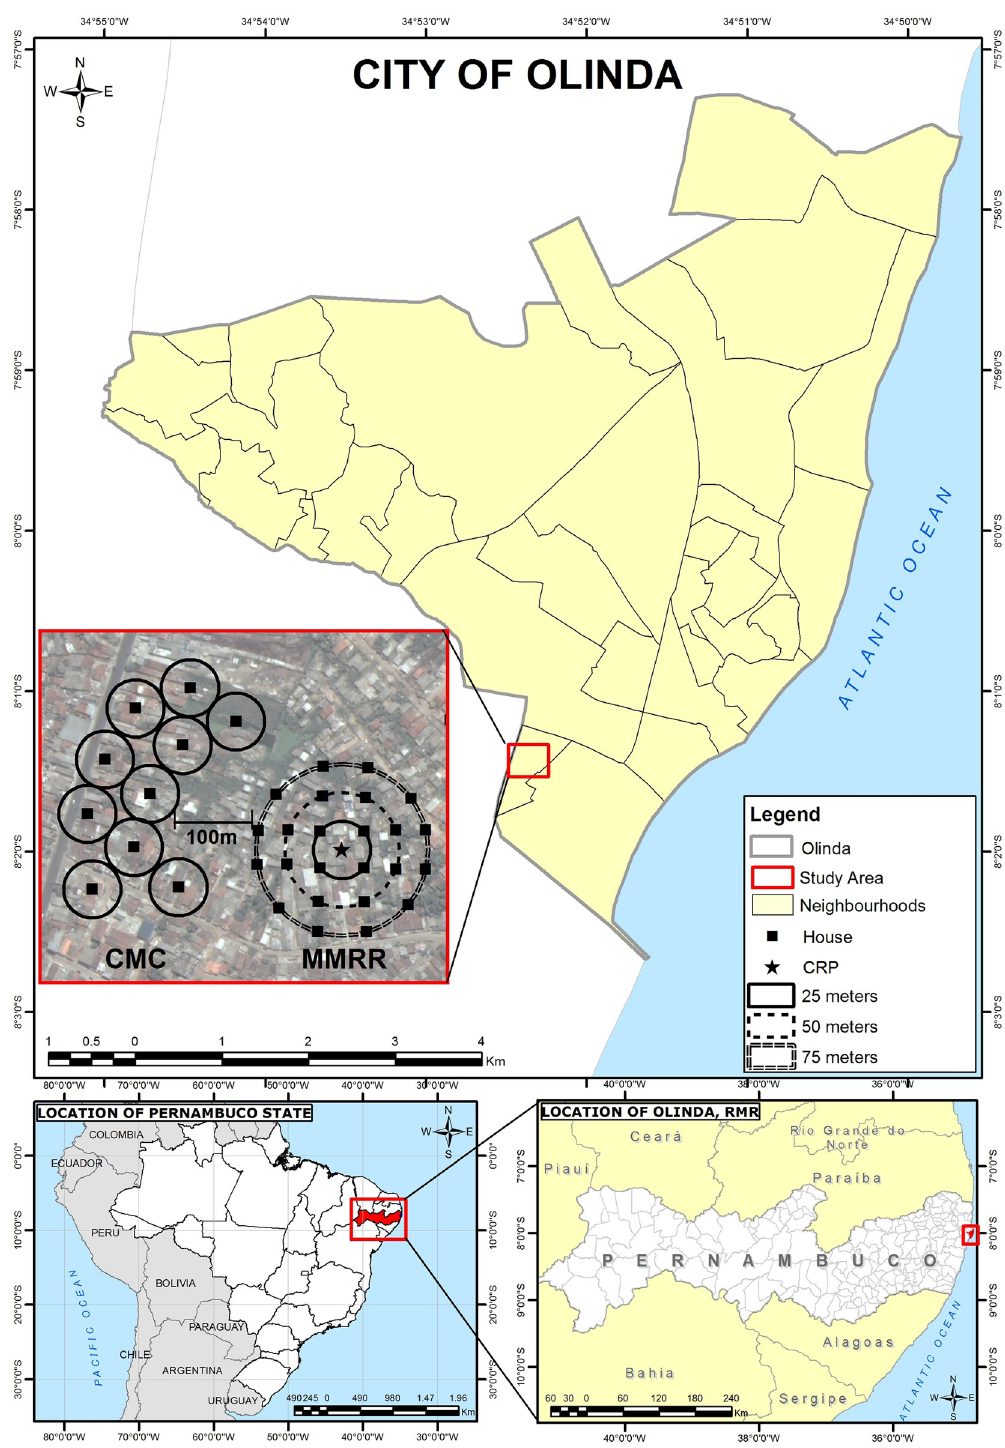
Fig 1. Map of city of Olinda, Recife Metropolitan Region (RMR), Pernambuco State, Northeastern Brazil, and planned study sites within Sı´tio Novo: Collection method comparison (CMC); mosquito mark release recapture (MMRR); 100m buffer